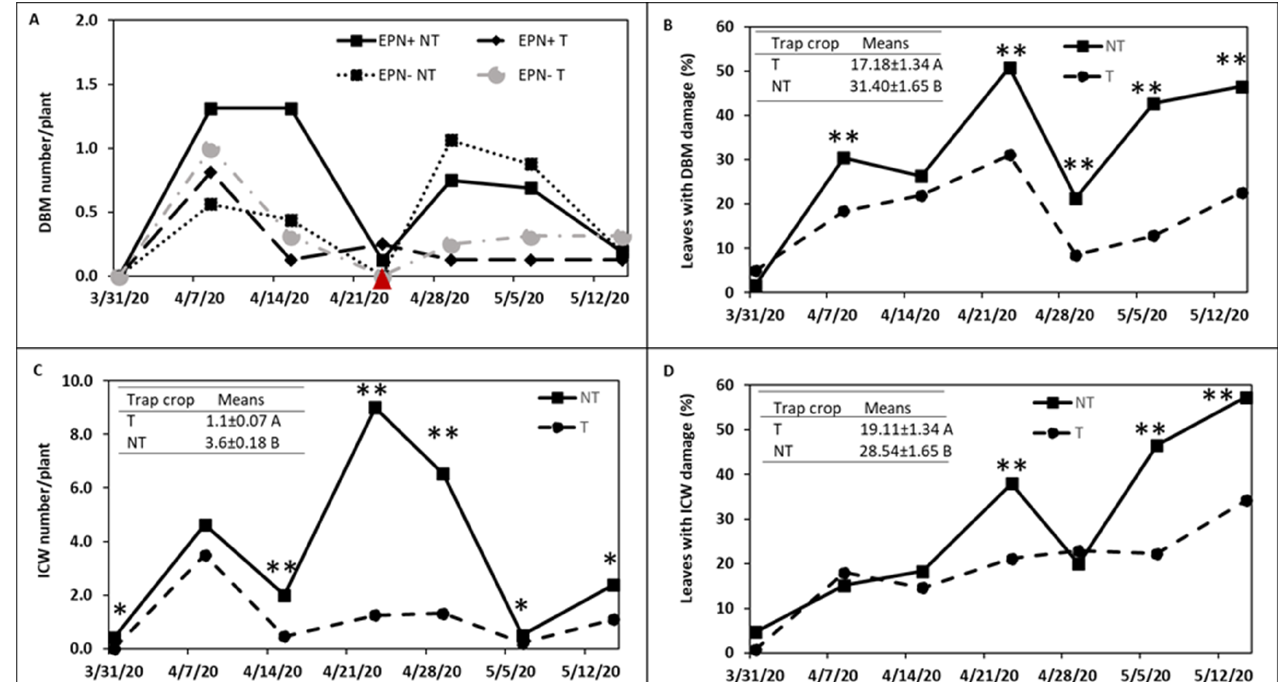
Figure 4. Effect of kai-choi as trap crop and entomopathogenic nematodes (EPN) on the reduction of ( A ) Abundance of diamondback moth (DBM) after EPN application; ( B ) Percentage of leaves with DBM damage; ( C ) Abundance of imported cabbageworm (ICW); ( D ) Percentage of leaves with ICW damage on head cabbage in Trial I. T = trap crop, NT = no trap crop. Δ Indicates EPN application. * and ** indicate significant differences between trap crop (T) and no trap crop (NT) at p ≤ 0.05 and 0.01, respectively. Means followed by the same letters are not different based on analysis of variance.